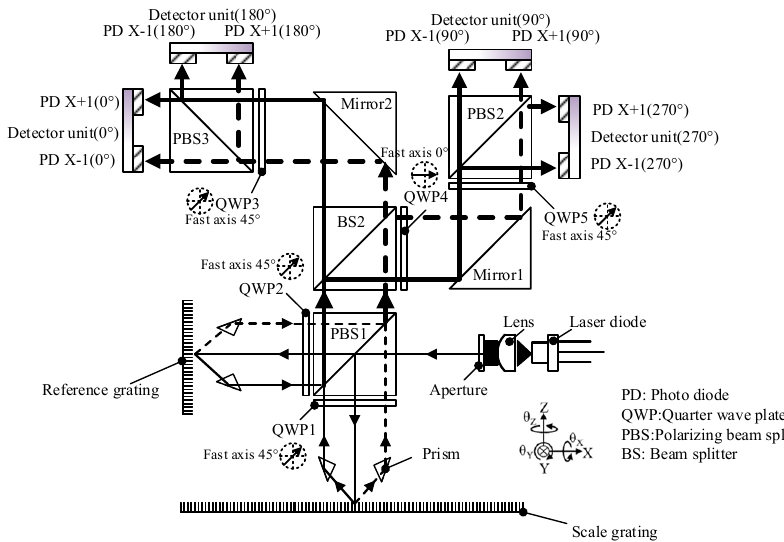
Figure 1. A typical optical layout of a grating encoder for which the proposed platform is